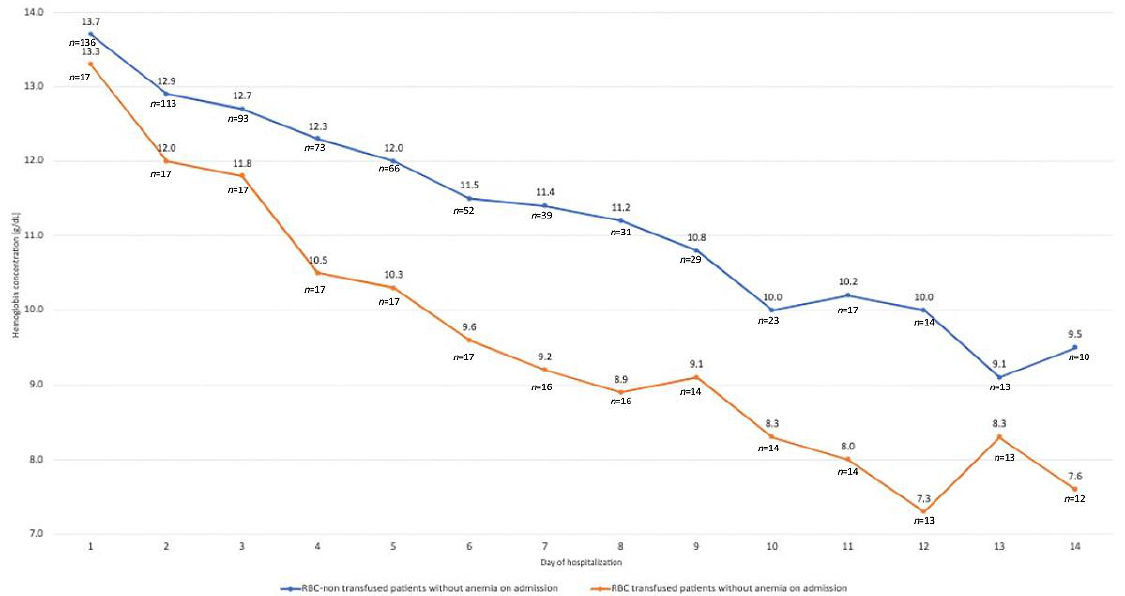
Figure 2. Hemoglobin concentration during first 14 days of hospitalization in patients without anemia on admission with regard to a need for RBC